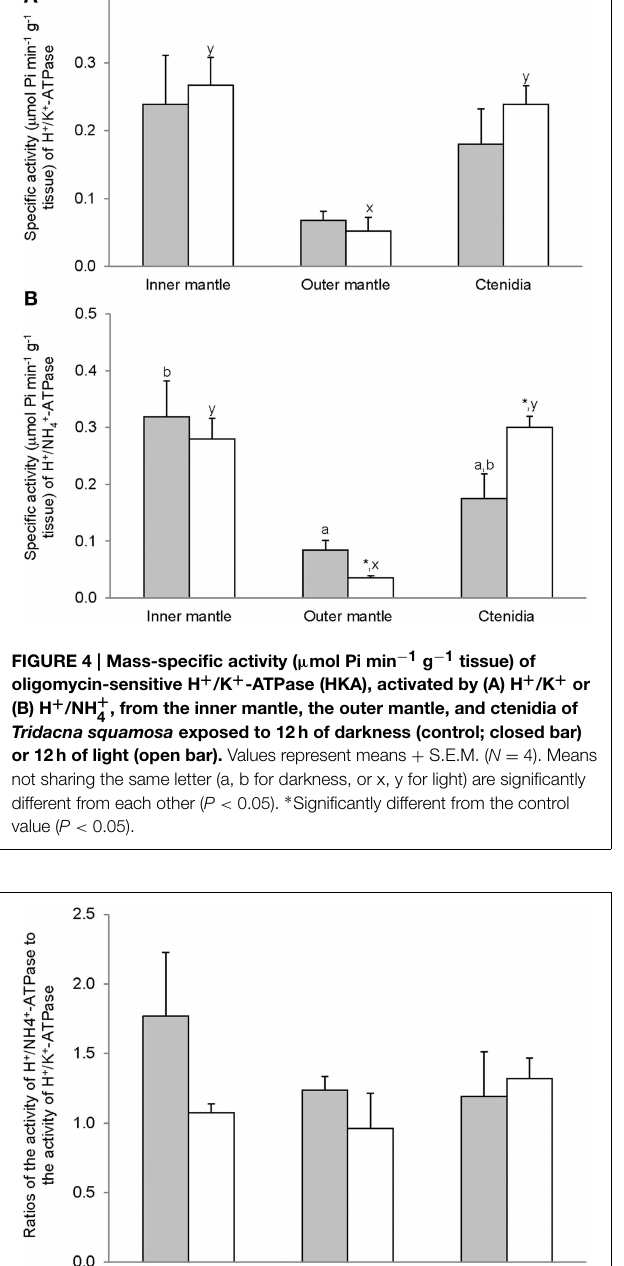
transport through ctenidia 4